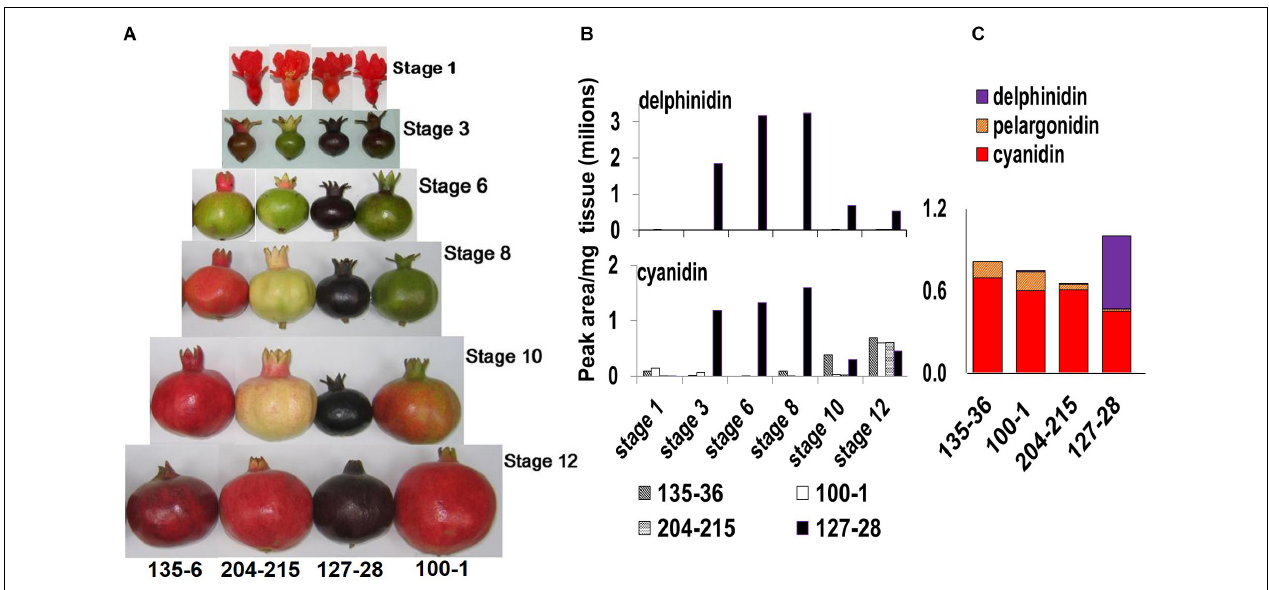
FIGURE 2 | Phenotypical and chemical characterization of the ‘Black’ pomegranate compared with various “red” pomegranate varieties. (A) Fruits of four pomegranate varieties at six different developmental stages (Ben-Simhon et al., 2011), from flower (stage 1) to fully mature fruit (stage 12). (B) Total level of delphinidin and its derivatives (purple color) and of cyanidin and its derivatives (red color) in the peel during the various developmental stages of the fruit in four pomegranate varieties. (C) Anthocyanin composition in the peel of ripe fruit- stage 12. The varieties shown are P.G.100-1, P.G.135-36, P.G.204-215, and P.G.127-28